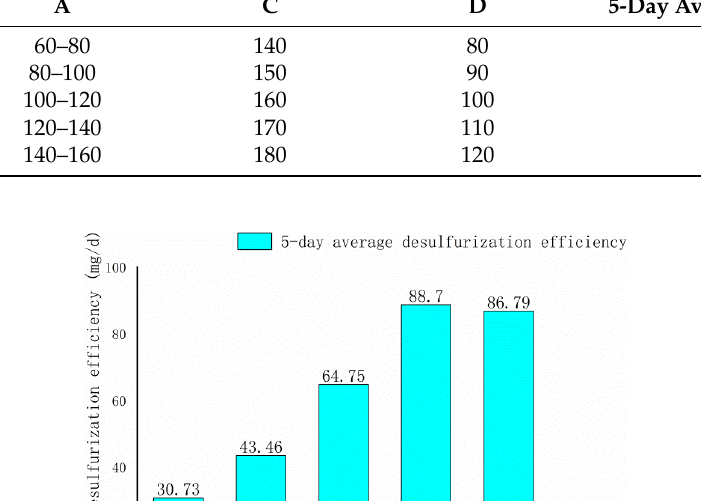
Table 4. The steepest climbing test results.